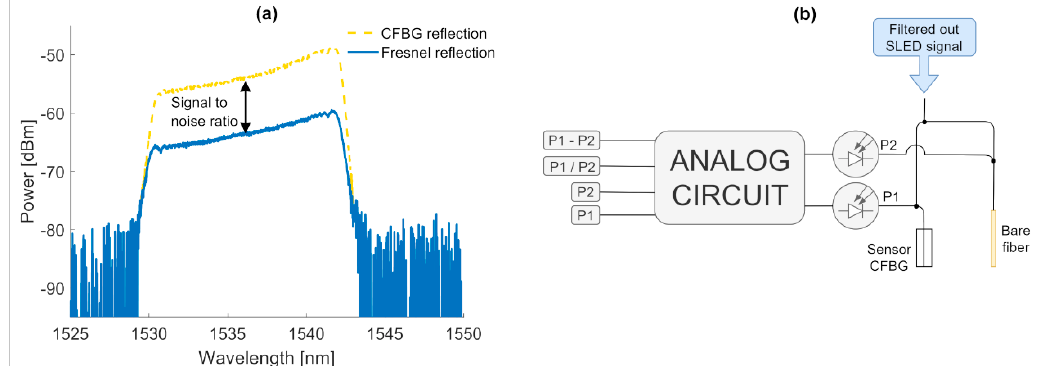
Figure 11. (a ) Reflected signal from the grating, together with an indication of the Fresnel reflection and ( b ) the system setup for monitoring of the Fresnel reflection.